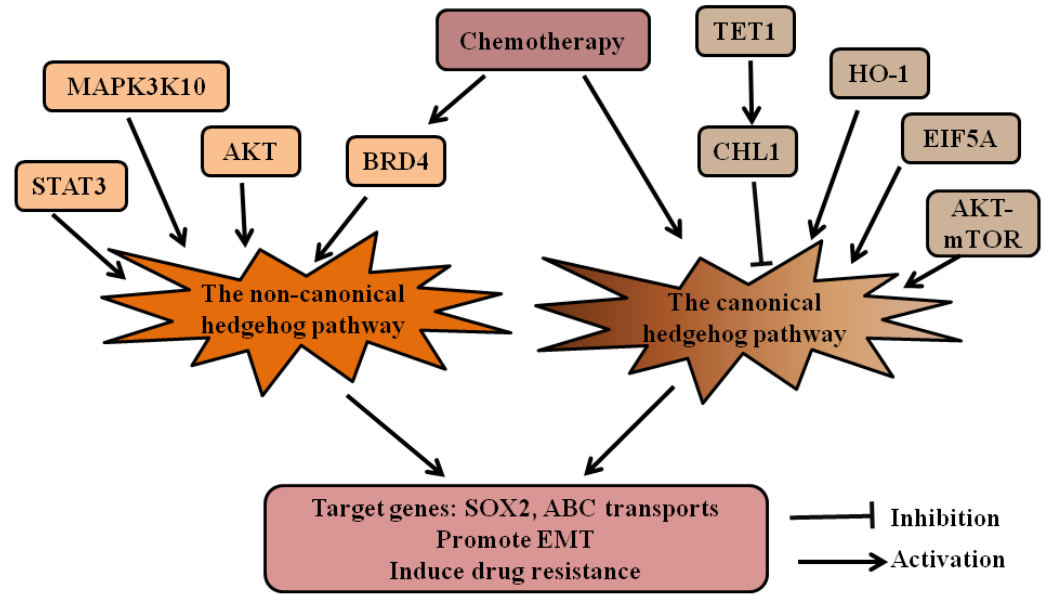
Figure 3. The HH pathway crosstalks with other signaling pathways in gastrointestinal cancers. The crosstalking of the canonical and non-canonical HH pathways with other pathways in drug resistance of gastrointestinal cancers are summarized. In gastrointestinal cancers, HO-1, ATK–mTOR, and EIF5A can activate the canonical HH pathway, while TET1 and CHL1 inhibit the canonical HH pathway. STAT3, MAP3K10, AKT, and BRD4 may activate the non-canonical HH pathway. Chemotherapy activates the HH pathway through different mechanisms. The active HH signaling increases expression of SOX2 and ABC transporters, promotes EMT, and induces drug resistance. Hedgehog (HH); heme oxygenase-1 (HO-1); mammalian target of rapamycin (mTOR); eukaryotic translation initiation factor 5A (EIF5A); signal transducer and activator of transcription 3 (STAT3); mitogen-activated protein kinase 10 (MAP3K10); bromodomain-containing protein 4(BRD4); ATP-binding cassette (ABC) transports; epithelial – mesenchymal transition (EMT).